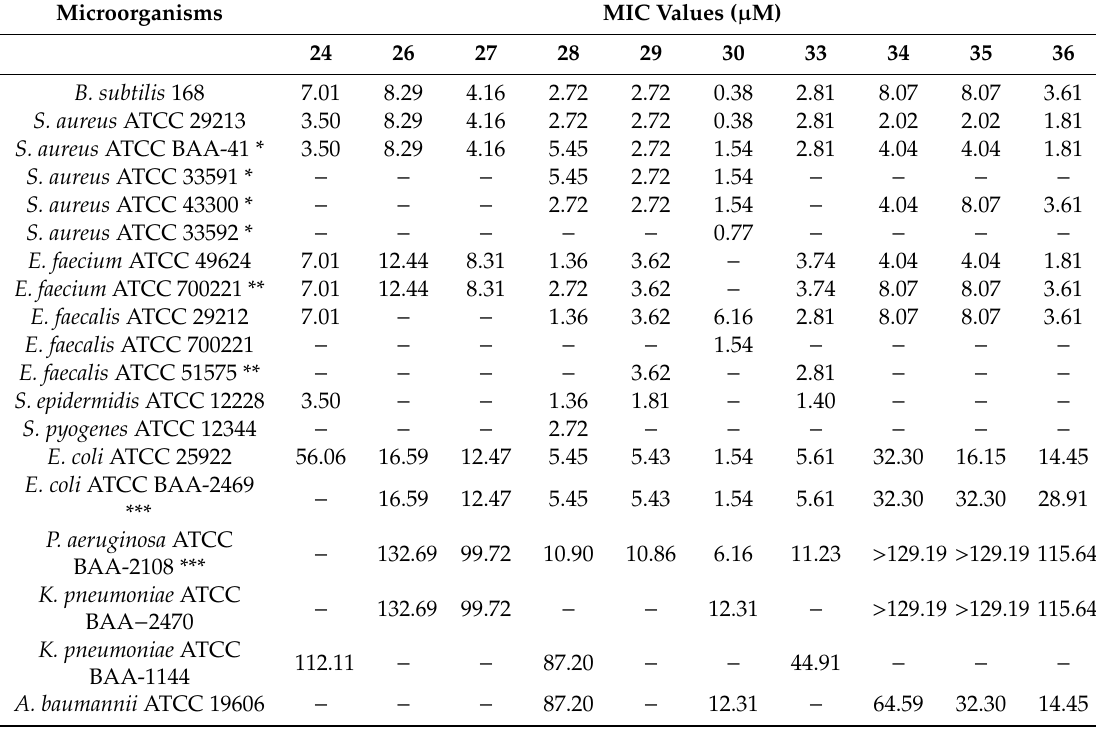
Table 3. Minimum inhibitory concentrations of the quinolinium and structurally related compounds.